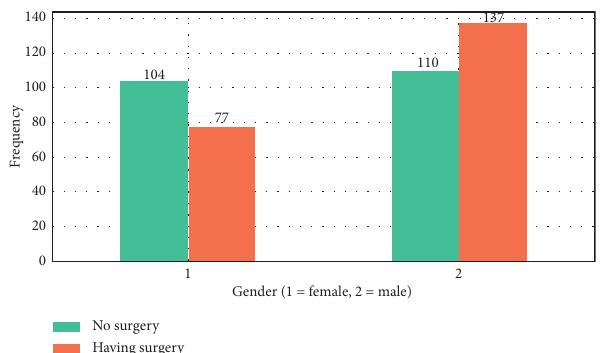
Figure 2: Graph of those who underwent surgery according to gender after data